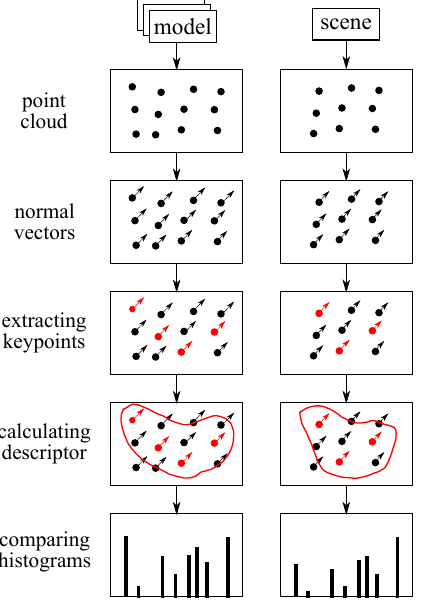
Figure 4. The process flow of object